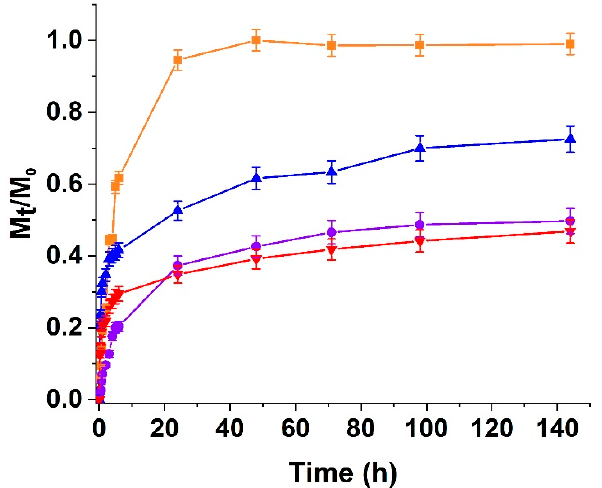
Figure 5. CUR release from 𝐻 (cid:3002)(cid:3017) (blue line), 𝐻 (cid:3002)(cid:2879)(cid:3008)(cid:3016)(cid:3017) (red line), 𝐻 (cid:3002)(cid:3004) (orange line) and 𝐻 (cid:3002)(cid:2879)(cid:3008)(cid:3016)(cid:3004) (violet line) as a function of time.